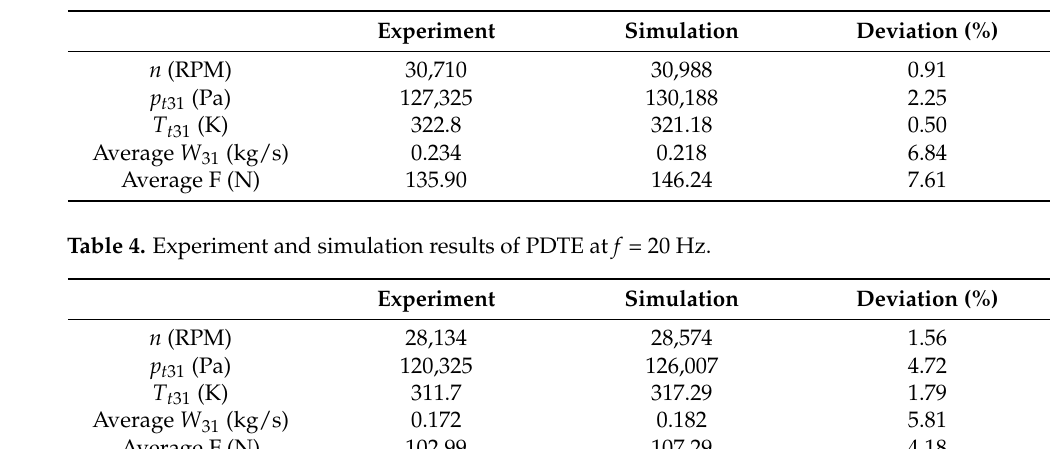
Table 3. Experiment and simulation results of PDTE at f = 15 Hz.